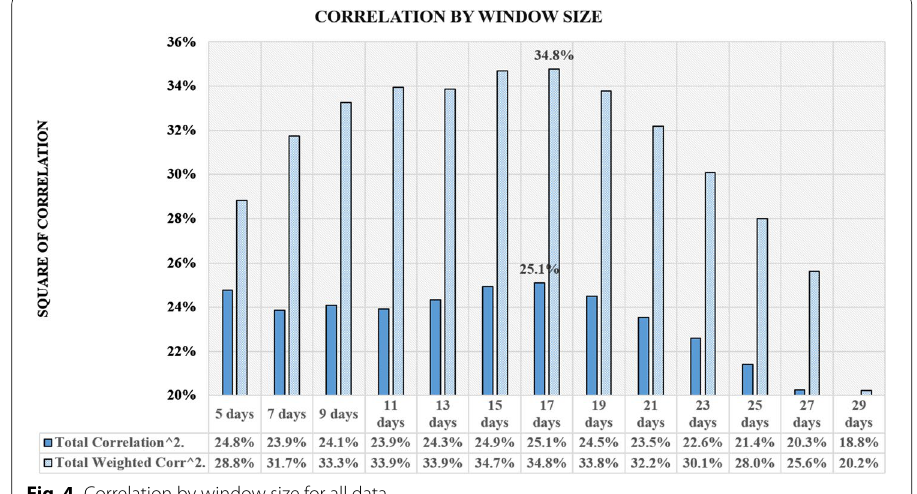
Fig. 4 Correlation by window size for all data